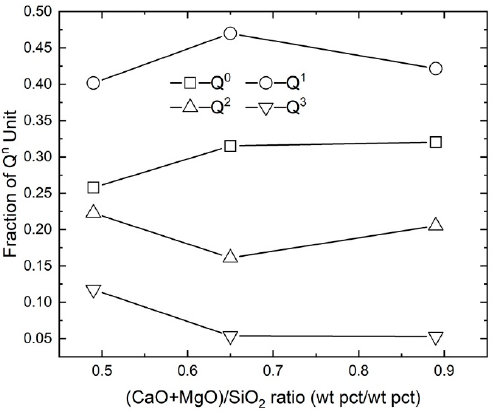
Figure 7. The abundance of structural units in FCSM slag as a function of basicity ( p O 2 = 10 − 8 atm and T = 1300 °C).